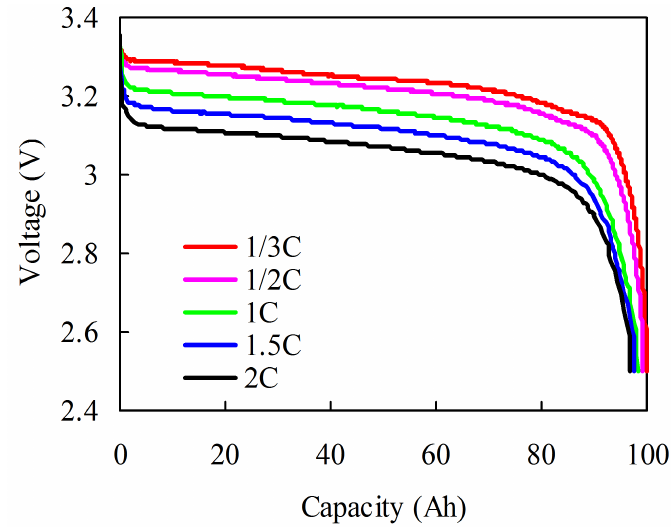
Figure 6. Discharged curves at different current